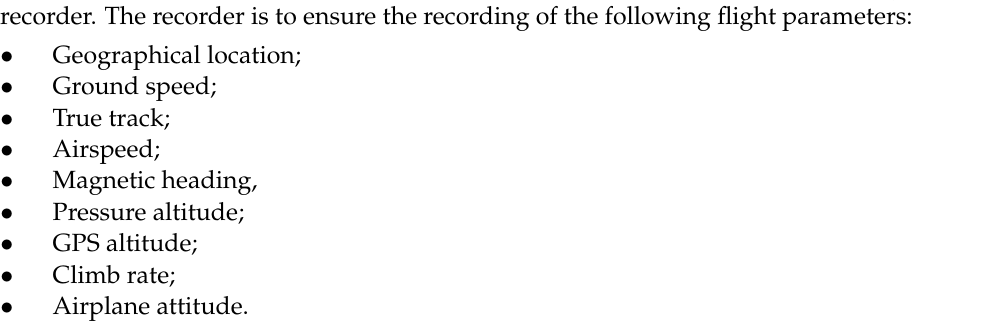
Figure 4. Observation sensor mounted in container under left wing ( A ); and camera installed on the right chassis ( B ).